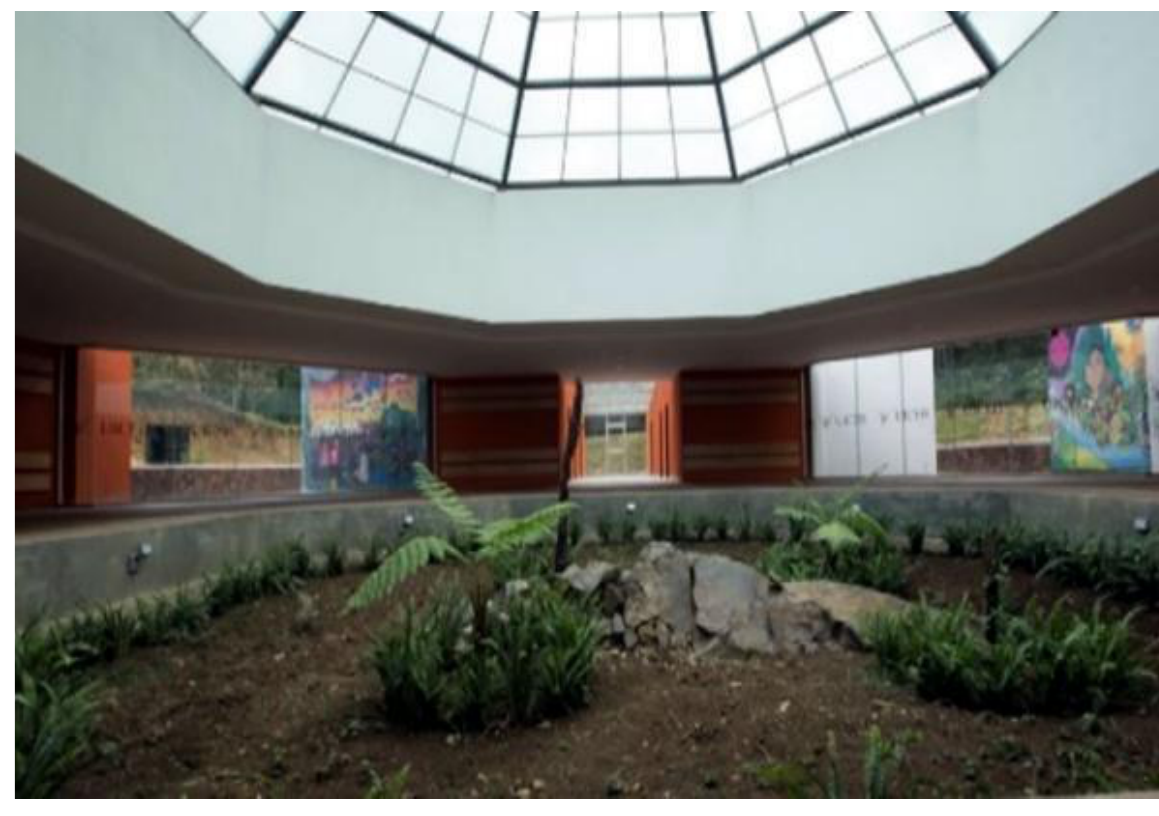
Figure 8, Student dome planter Source Dalia Peña